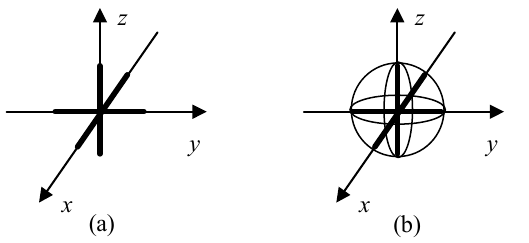
Figure 5. Structural models of the triad ( a ) and six-component ( b ) designs.